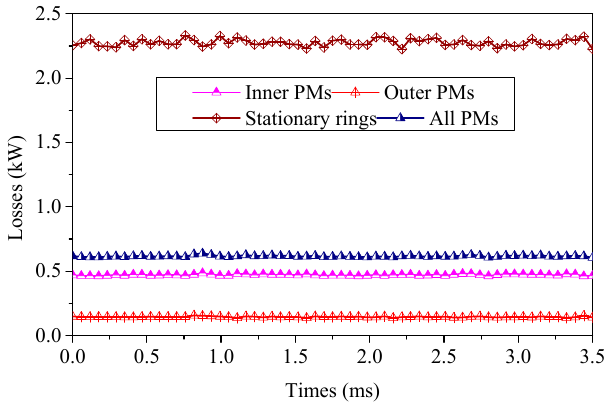
Figure 3. Losses of surface-mounted magnetically geared (MG) machine with inner rotor 5400 r/min.